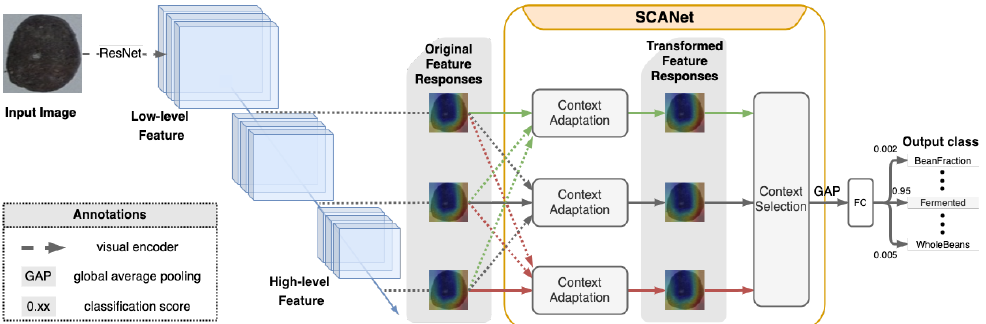
Figure 2. Our proposed Selective Context Adaptation Network